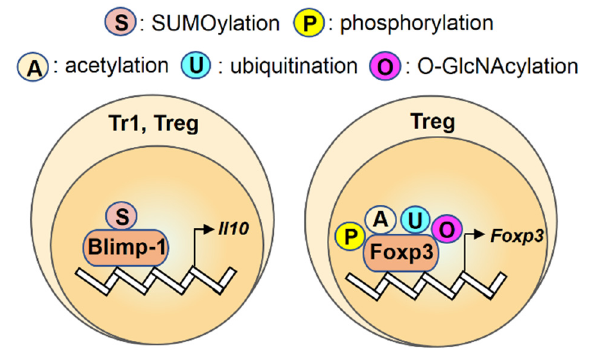
Figure 3. An overview of regulation for transcription factors Blimp-1 and Foxp3 by post-translational modifications in Tr1 and Treg cells. Transcription factors Blimp-1 and Foxp3 are regulated by the post-translational modifications (S: SUMOylation; P: phosphorylation; A: acetylation; U: ubiquitination; O: O-GlcNAcylation) and the color differences indicate various modifications on their targets.